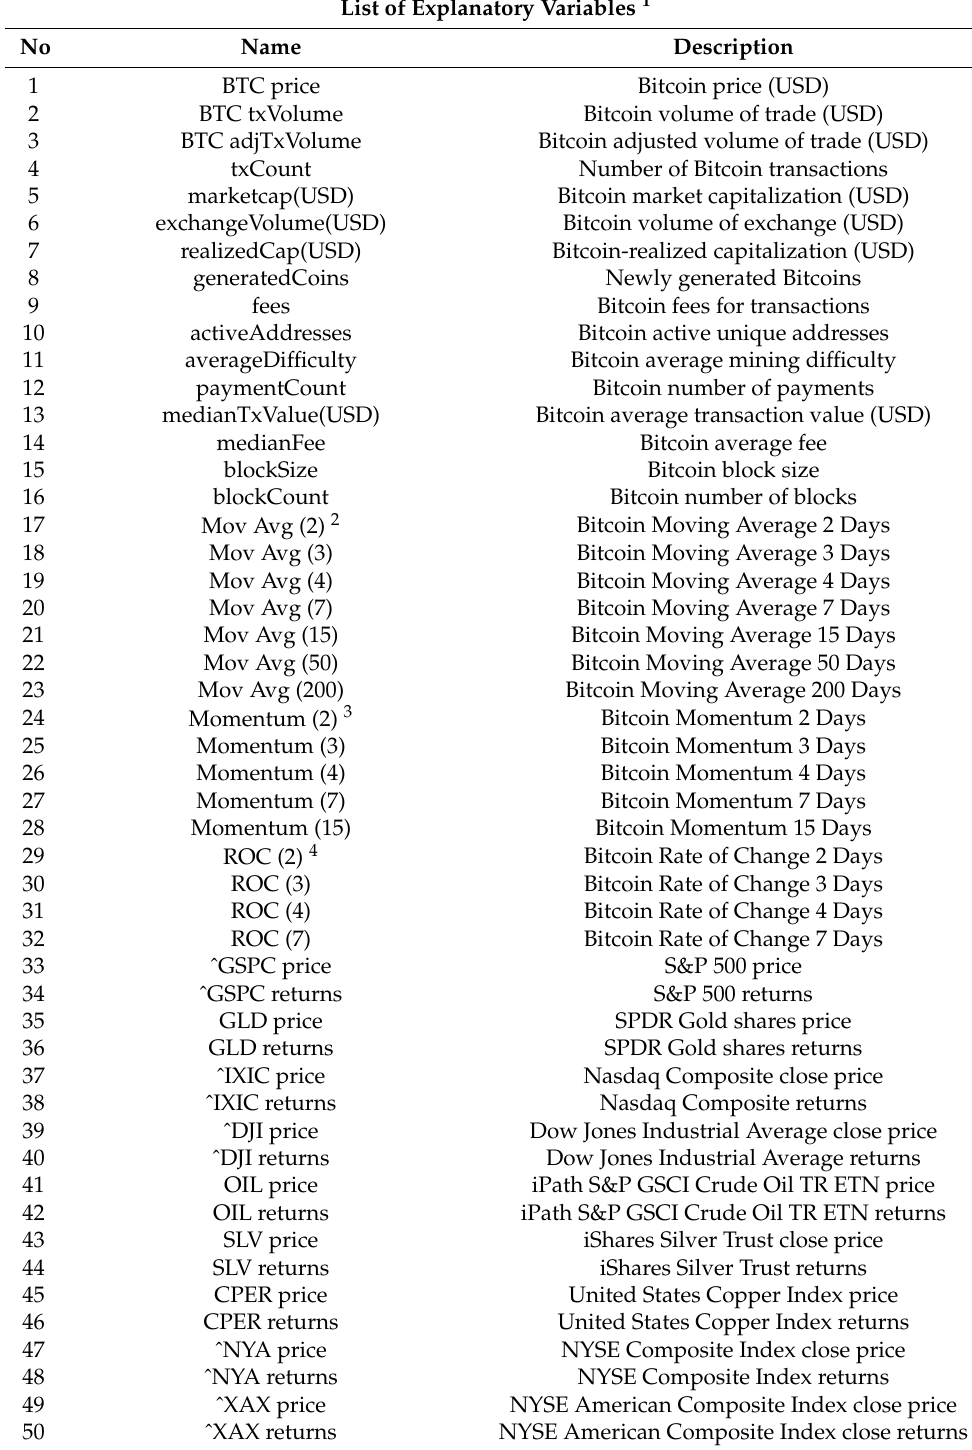
Table A1. The full list of the variables